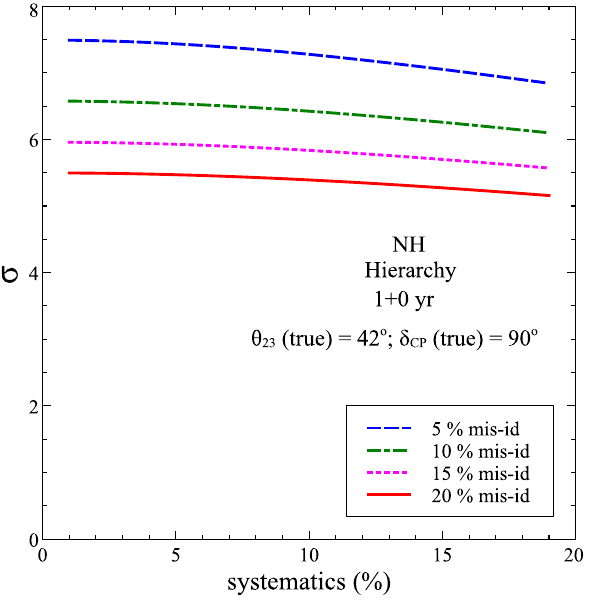
Fig. 4 Effect of background and systematics in hierarchy sensitivity for NH. This is shown for θ 23 (true) = 42 ◦ and δ CP (true) = 90 ◦ as for this set of parameters the χ 2 is minimum in